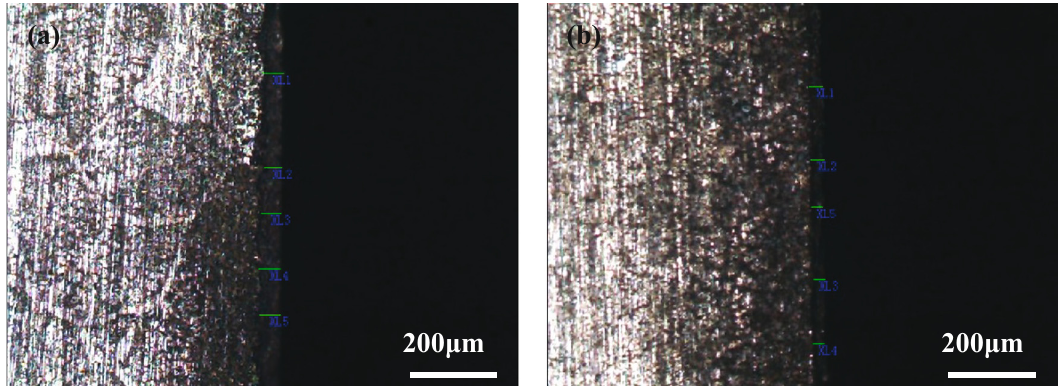
Figure 7: The morphology of corrosion in brass alloy with and without EPT ( a ) original sample and ( b ) 3 Hz.